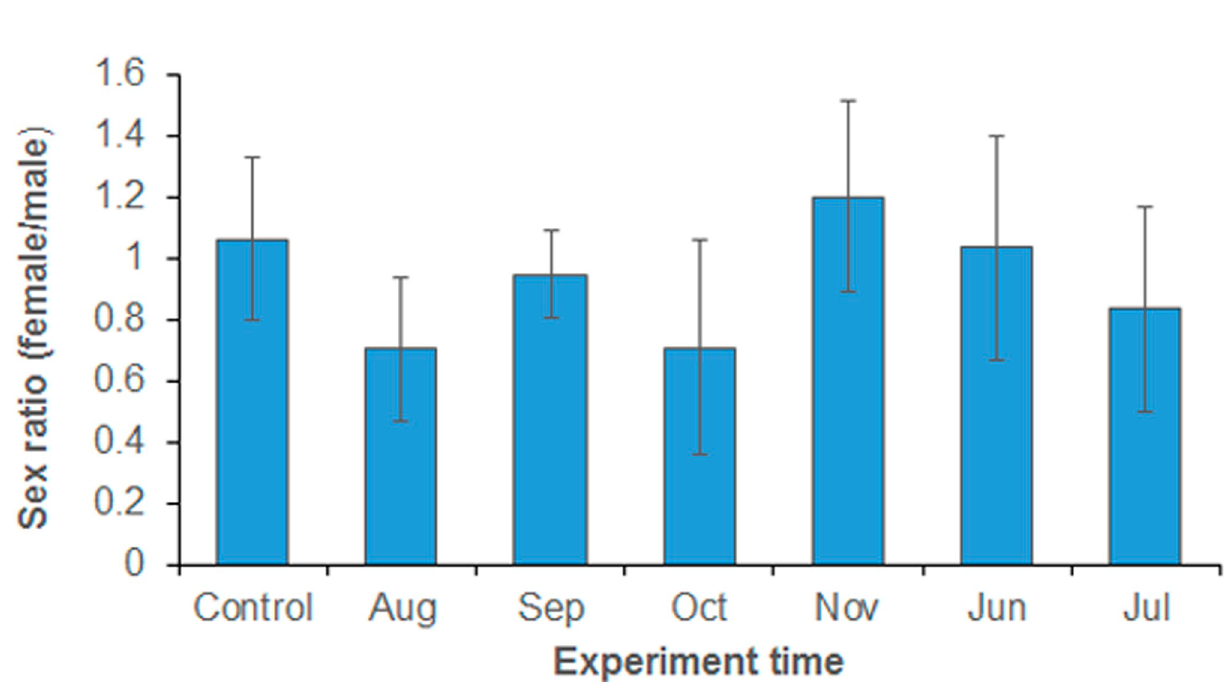
Fig 8. Sex ratio of emerged adults.